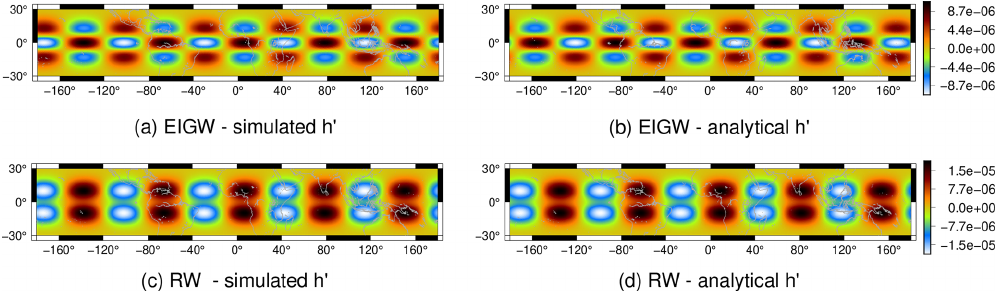
Figure 15. Matsuno baroclinic wave test case: simulated h (cid:48) for the EIGW in the rotated VR7 grid (a) and the analytical h (cid:48) (b) after 100 EIGW periods (190d). In (c) and (d) we depict the simulated and analytical h (cid:48) for the Rossby wave in the rotated VR7 grid after 100 RW periods (1850d).